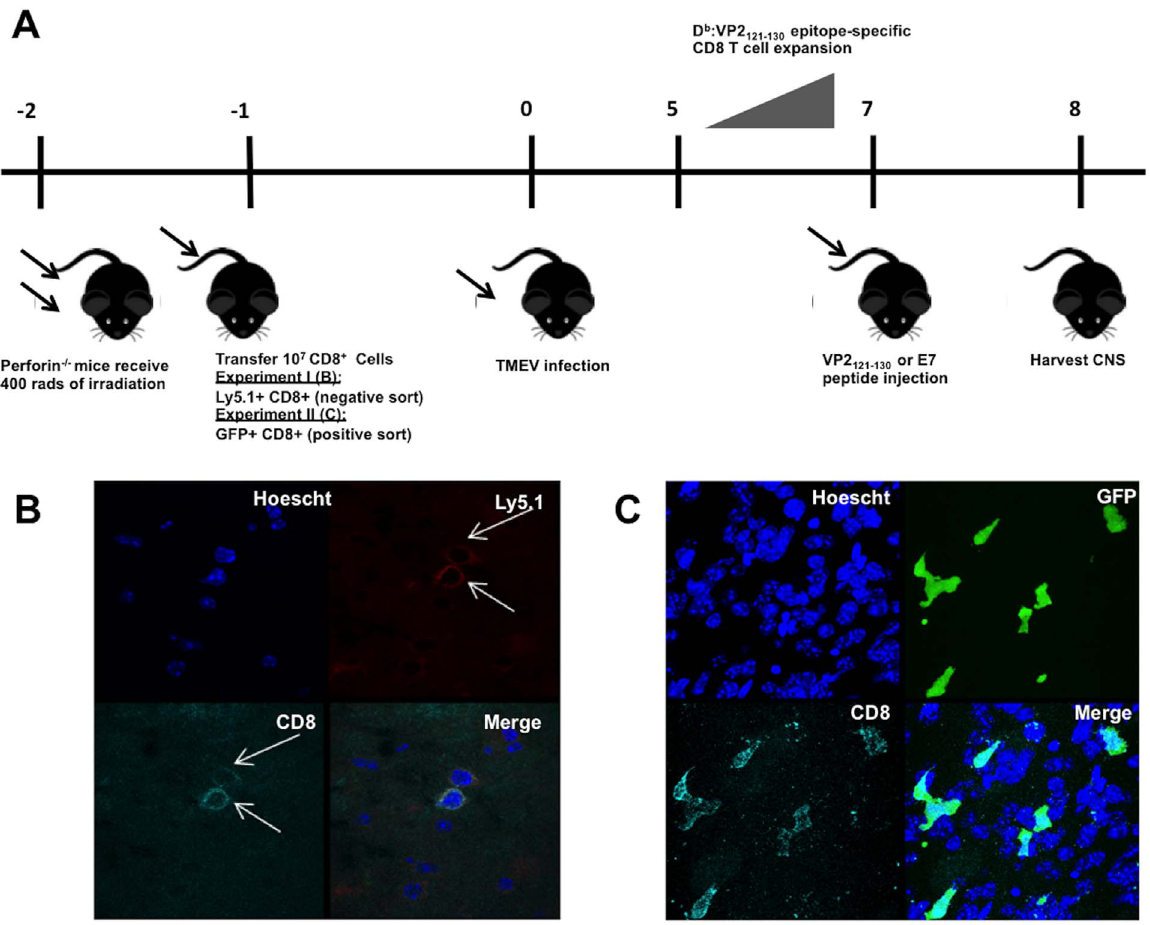
Figure 1. Adoptive transfer of CD8 + cells successfully migrate to brain post induction of PIFS. (A) Schematic illustrating the adoptive transfer of sorted perforin competent CD8 + cells into perforin 2 / 2 mice followed by induction of PIFS. C57BL/6 perforin 2 / 2 mice were irradiated with 400 rads of irradiation and then intravenously injected with 10 7 GFP + CD8 + splenocytes (n=10) or 10 7 Ly5.1 + CD8 + splenocytes (n=10). Mice were intracranially infected with TMEV on the following day. PIFS-inducing VP2 121–130 peptide or mock E7 control peptide were intravenously administered on day 7, during the peak of CD8 T cell expansion. MRI analysis was performed on the following day to visualize the extent of CNS vascular permeability and then the CNS was harvested for additional assays. Both negative (Experiment I) and positive (Experiment II) sort experiments yielded high purity of CD8 + T cell transfer. (B) Representative confocal microscopic images illustrating co-localization of Ly5.1 and CD8 protein (Experiment I). CNS-infiltrating Ly5.1 + cells colocalized with CD8 + cells 85.7% of the time as measured by confocal analysis. (C) Confocal microscopy showing of representative brain tissue slice showing successful transfer of GFP + CD8 + T cells (Experiment II). Purity of transfer was analyzed via flow cytometry, 98.0% + 2 0.5% of cells that were CD8 positive and GFP